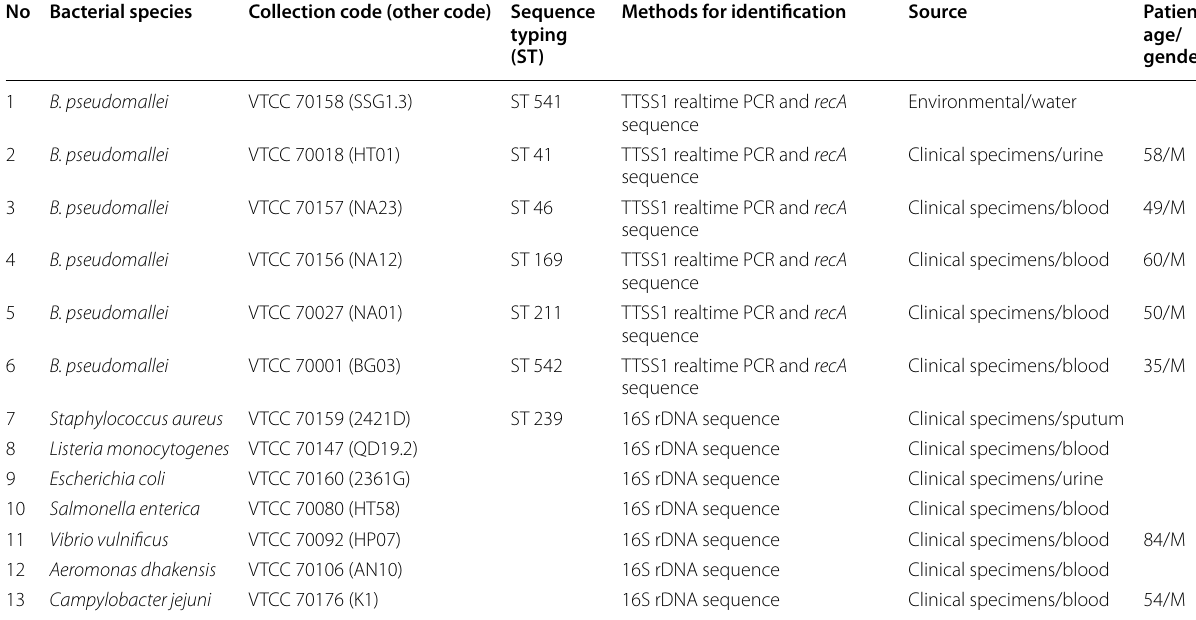
Table 1 List of bacterial strains used No Bacterial